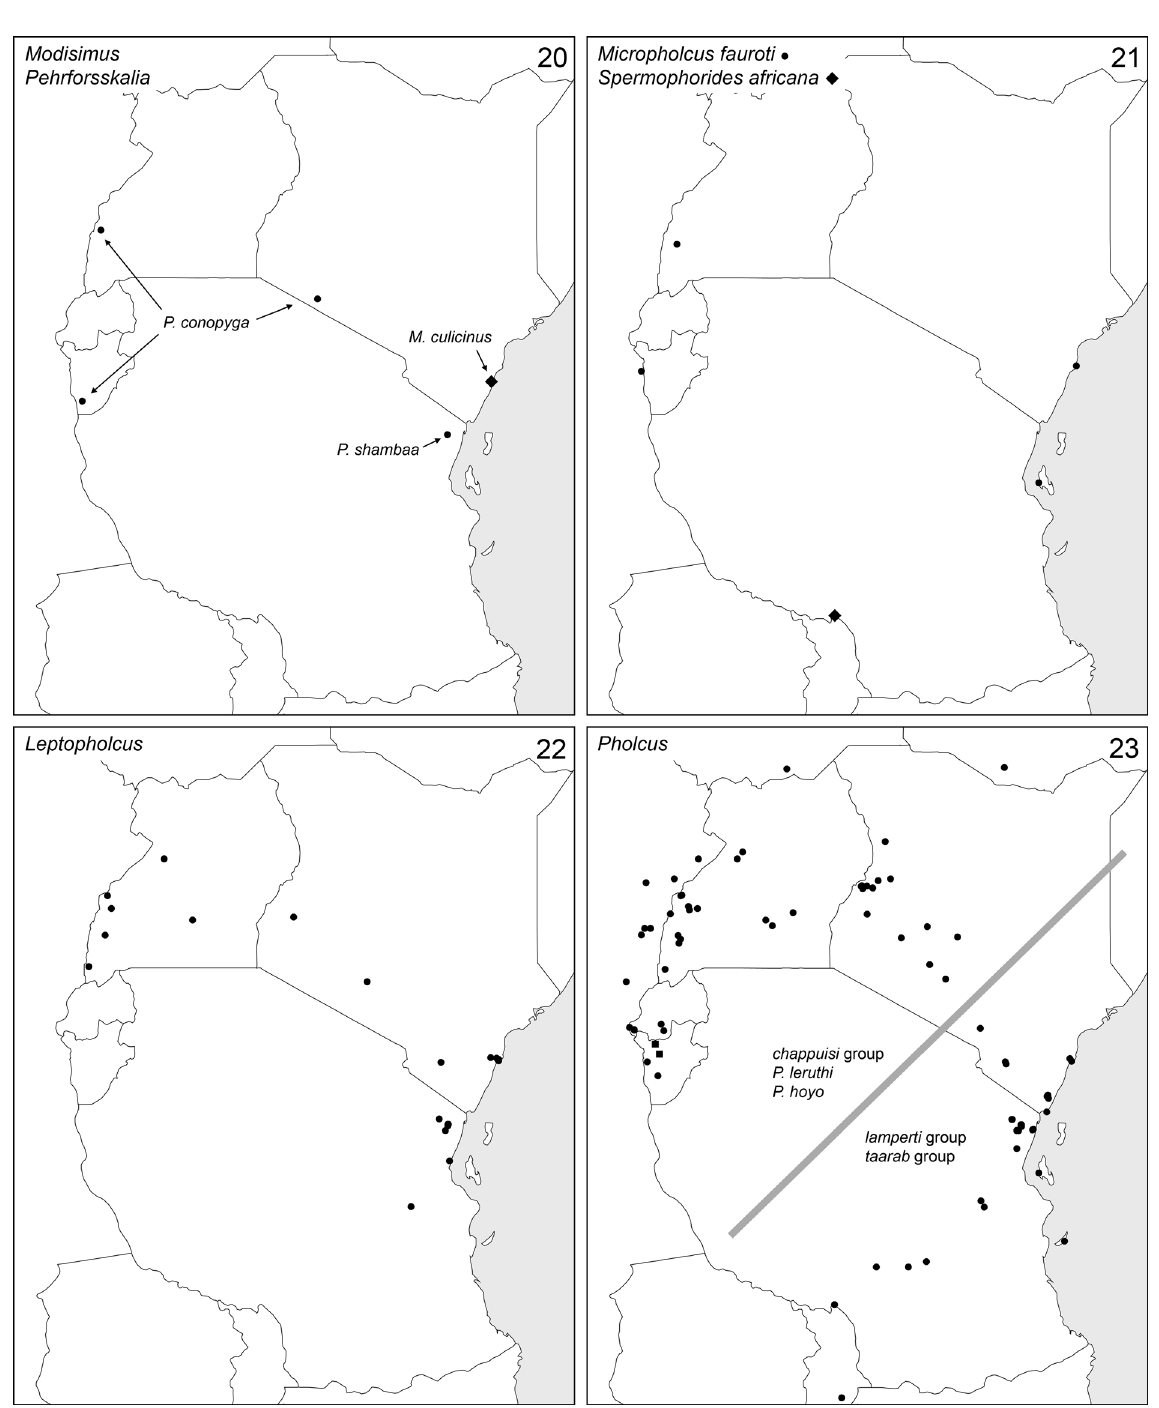
Figs 20-23. Known distributions of the genera Modisimus , Pehrforsskalia , Micropholcus, Spermophorides , Leptopholcus , and Pholcus in east Africa. For detailed maps of Leptopholcus and Pholcus , see Huber (2011). Squares: unidentified/undescribed